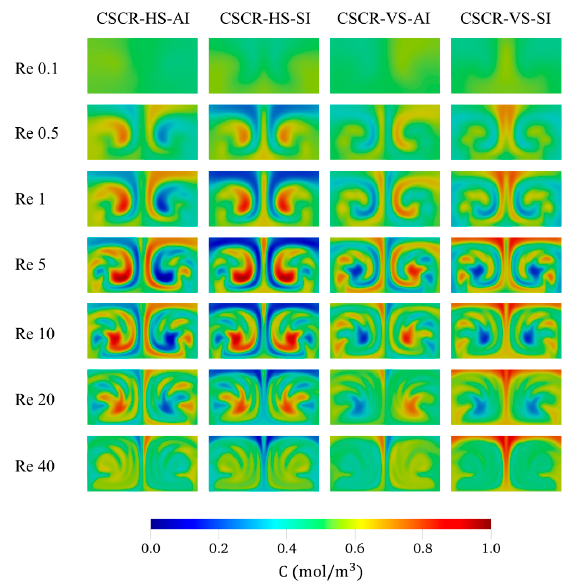
Figure 13. Concentration distributions at the outlet of the CSCR micromixer configurations examined ( D = D 1 ).